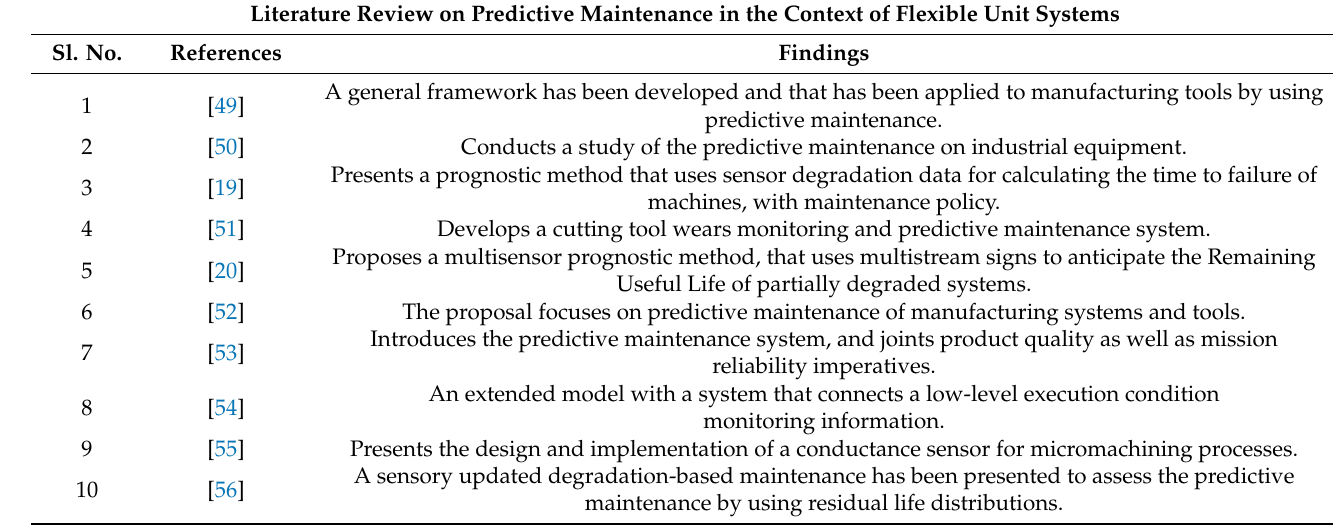
Table 10. Literature review on predictive maintenance related to flexible unit systems. Literature Review on Predictive Maintenance in the Context of Flexible Unit Systems Sl.